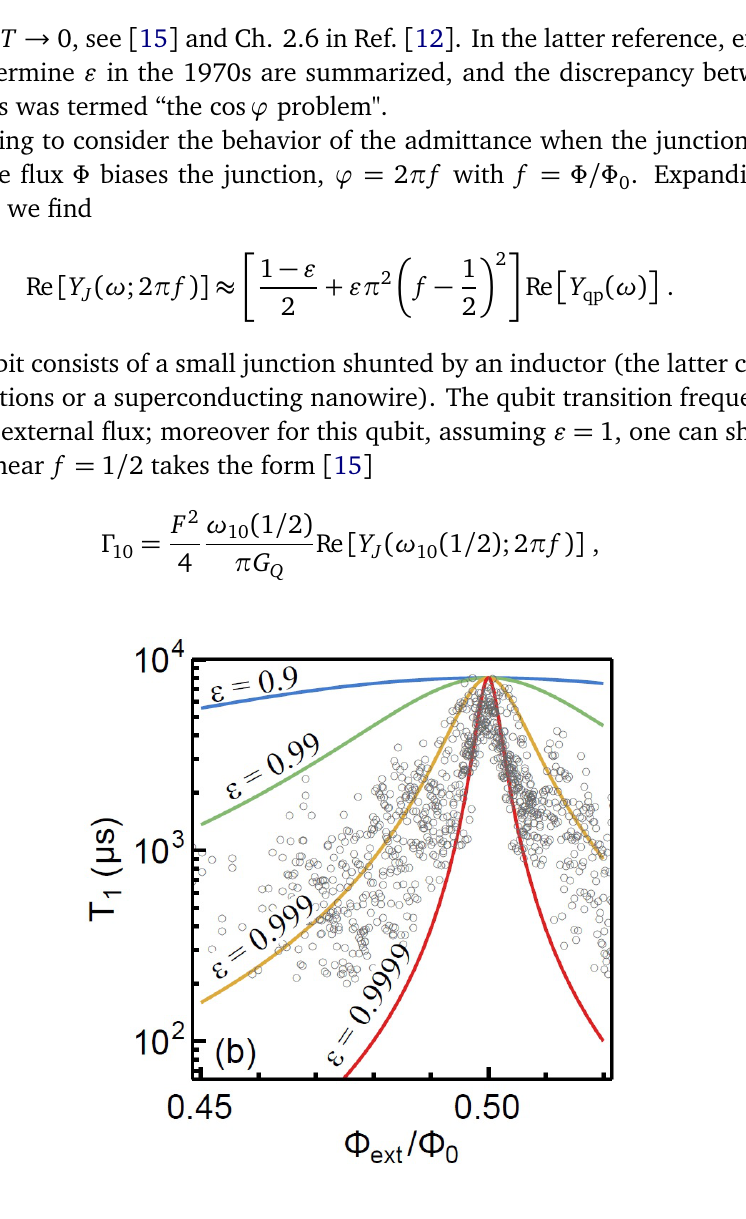
at different val- 1